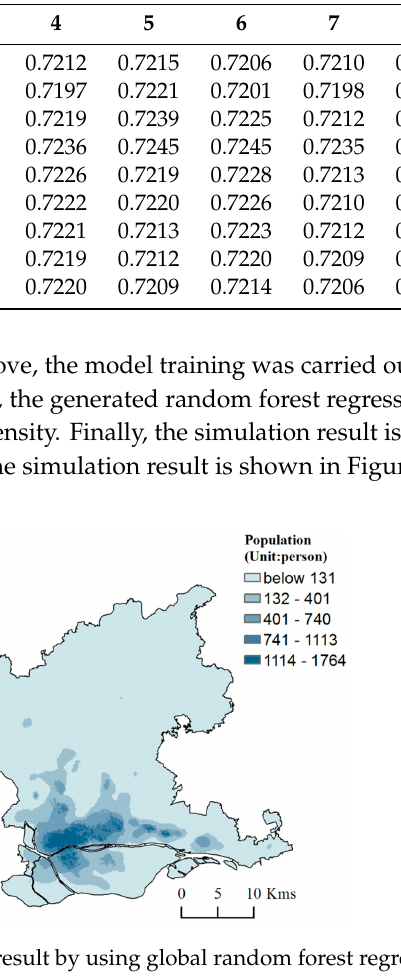
Table 4. The ten-fold cross validation for the proper parameters in the random forest.